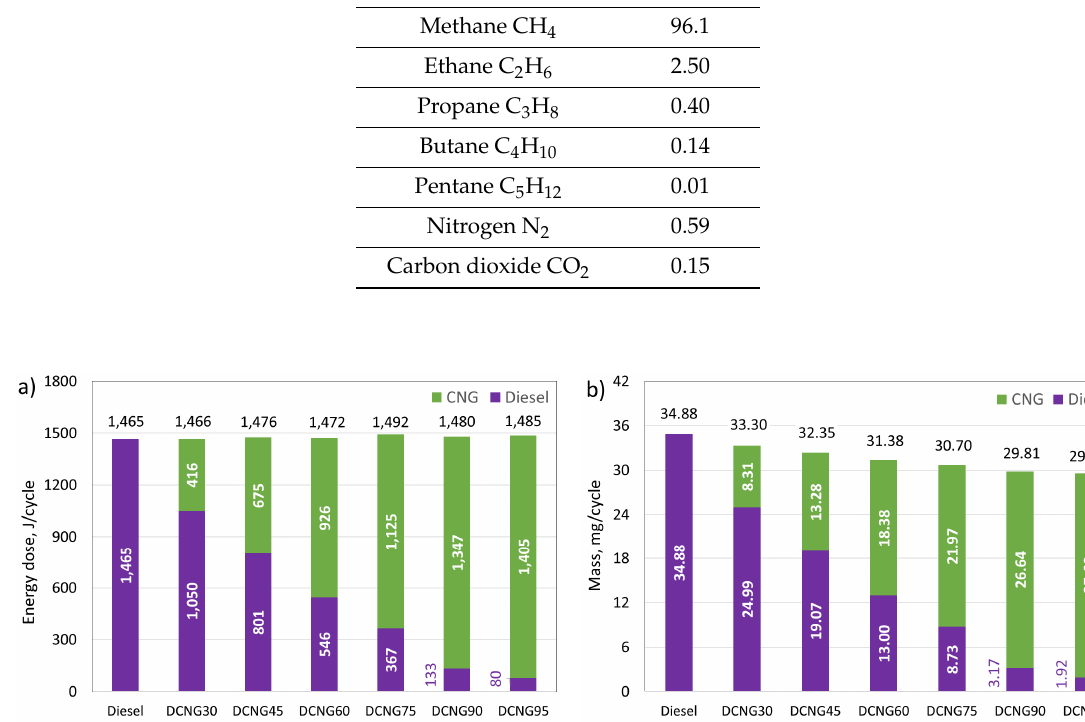
Figure 2. Energy ( a ) and mass ( b ) of the fuel delivered to the engine per one work cycle.